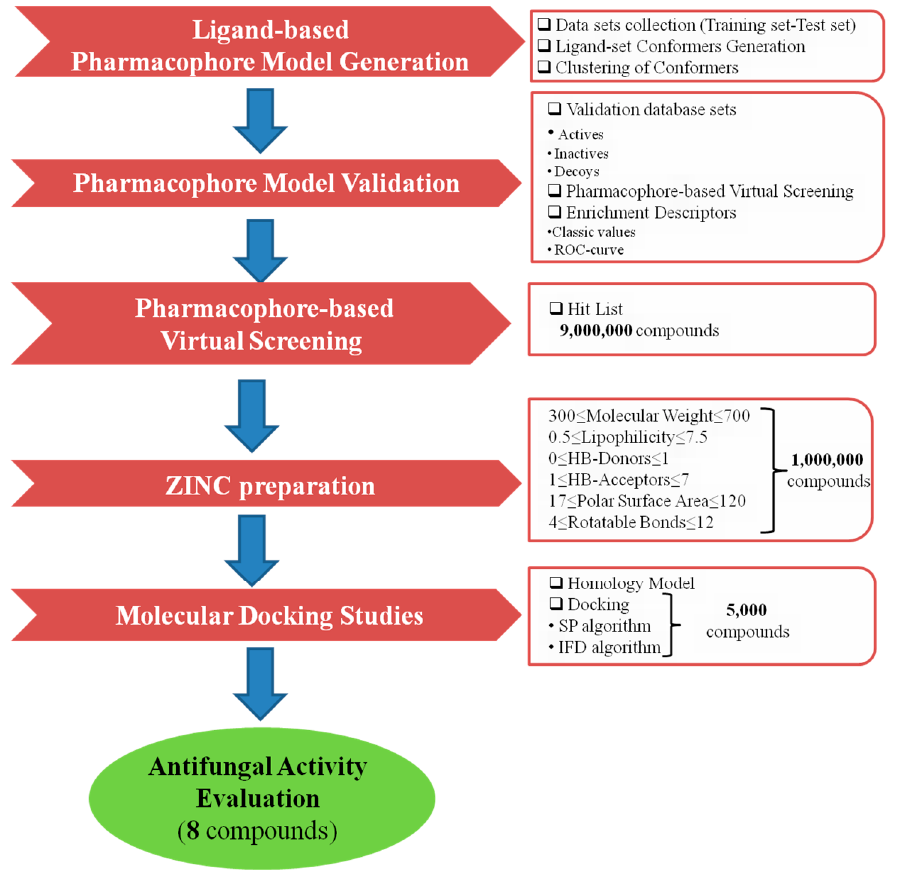
Figure 1. Virtual screening protocol workflow.